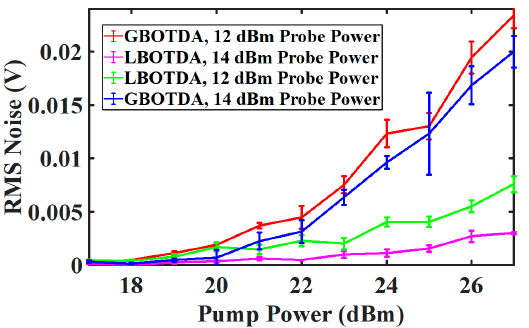
Figure 7. Experimental SBS-induced noise measurement in dependence on the pump power for G-BOTDA and L-BOTDA for − 12 dBm and − 14 dBm probe power. The error bars represent the standard deviation error of four measurements at each step.